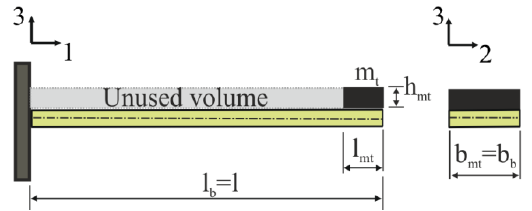
Figure 11. Unused volume according to the position of the tip mass.